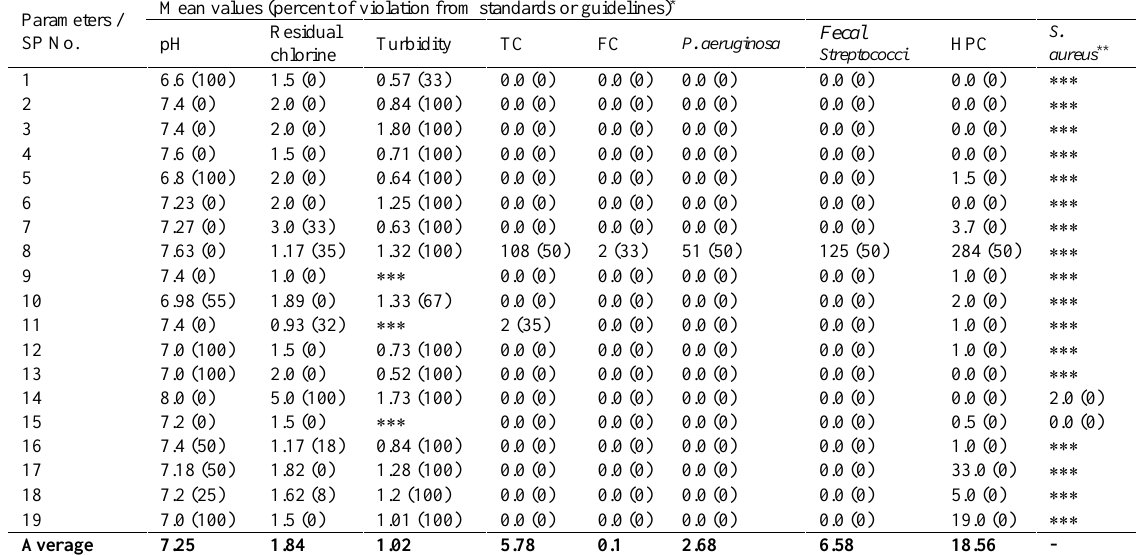
* Measurement units: pH: no unit; Residual chlorine: mg/L; Turbidity: NTU; TC and FC: MPN/100mL; Pseudomonas aeruginosa and HPC: cfu/mL; Fecal Streptococci and Staphylococcus aureus : colony/100mL. ** This parameter was sporadically measured in 2011, but measured on a regular basis during the next years. *** Not measured or data not available.